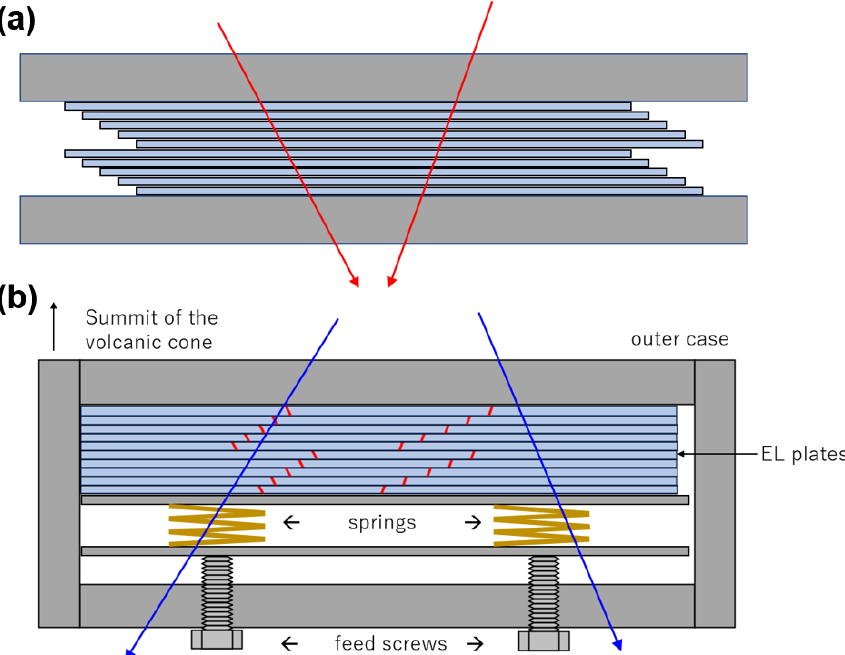
Figure 3. (a) View of the EL plates from above during standby. The EL plates were intentionally shifted a few millimeters horizontally and fixed with a pair of steel plates and a clamp. The red lines represent the muon tracks in this alignment. (b) View from above during the observations. The EL plates were aligned to the side of the outer box, and fixed by the springs and feed screws. The blue lines represent muon tracks during observations. Note that the red tracks cannot be reconstructed in this alignment.